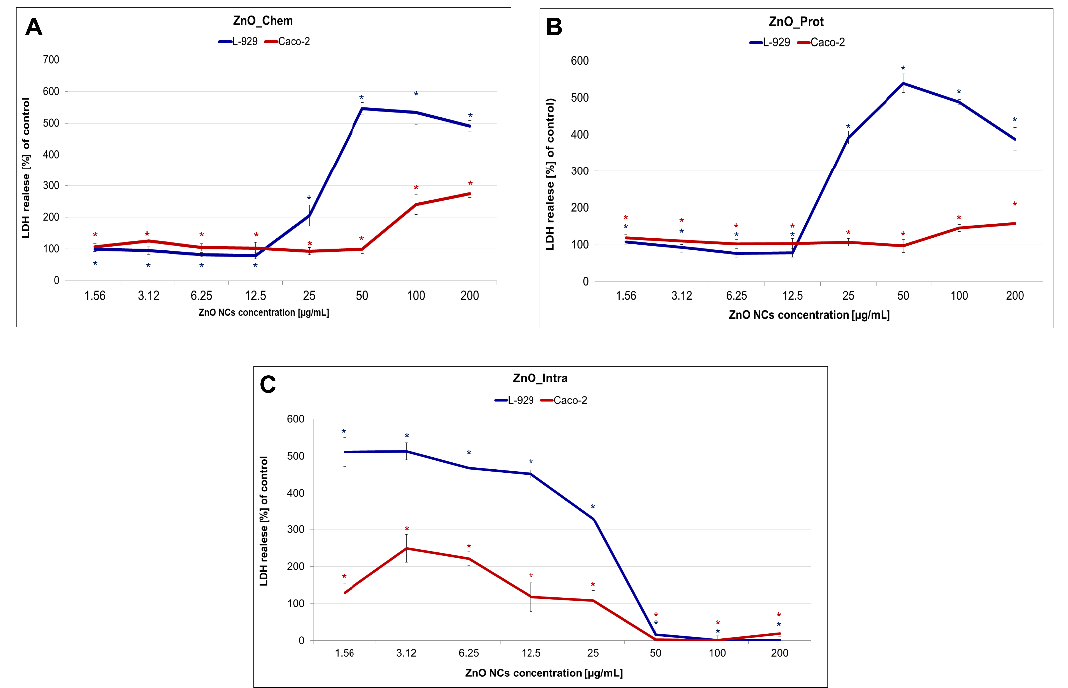
Figure 4. LDH leakage level of Caco-2 and L929 cells treated with different concentrations of ( A ) chemically, ( B ) biochemically and ( C ) intracellularly synthetized ZnO NPs. The values are expressed as mean ± SD values of three independent experiments ( n = 3); * p < 0.001 (ANOVA).